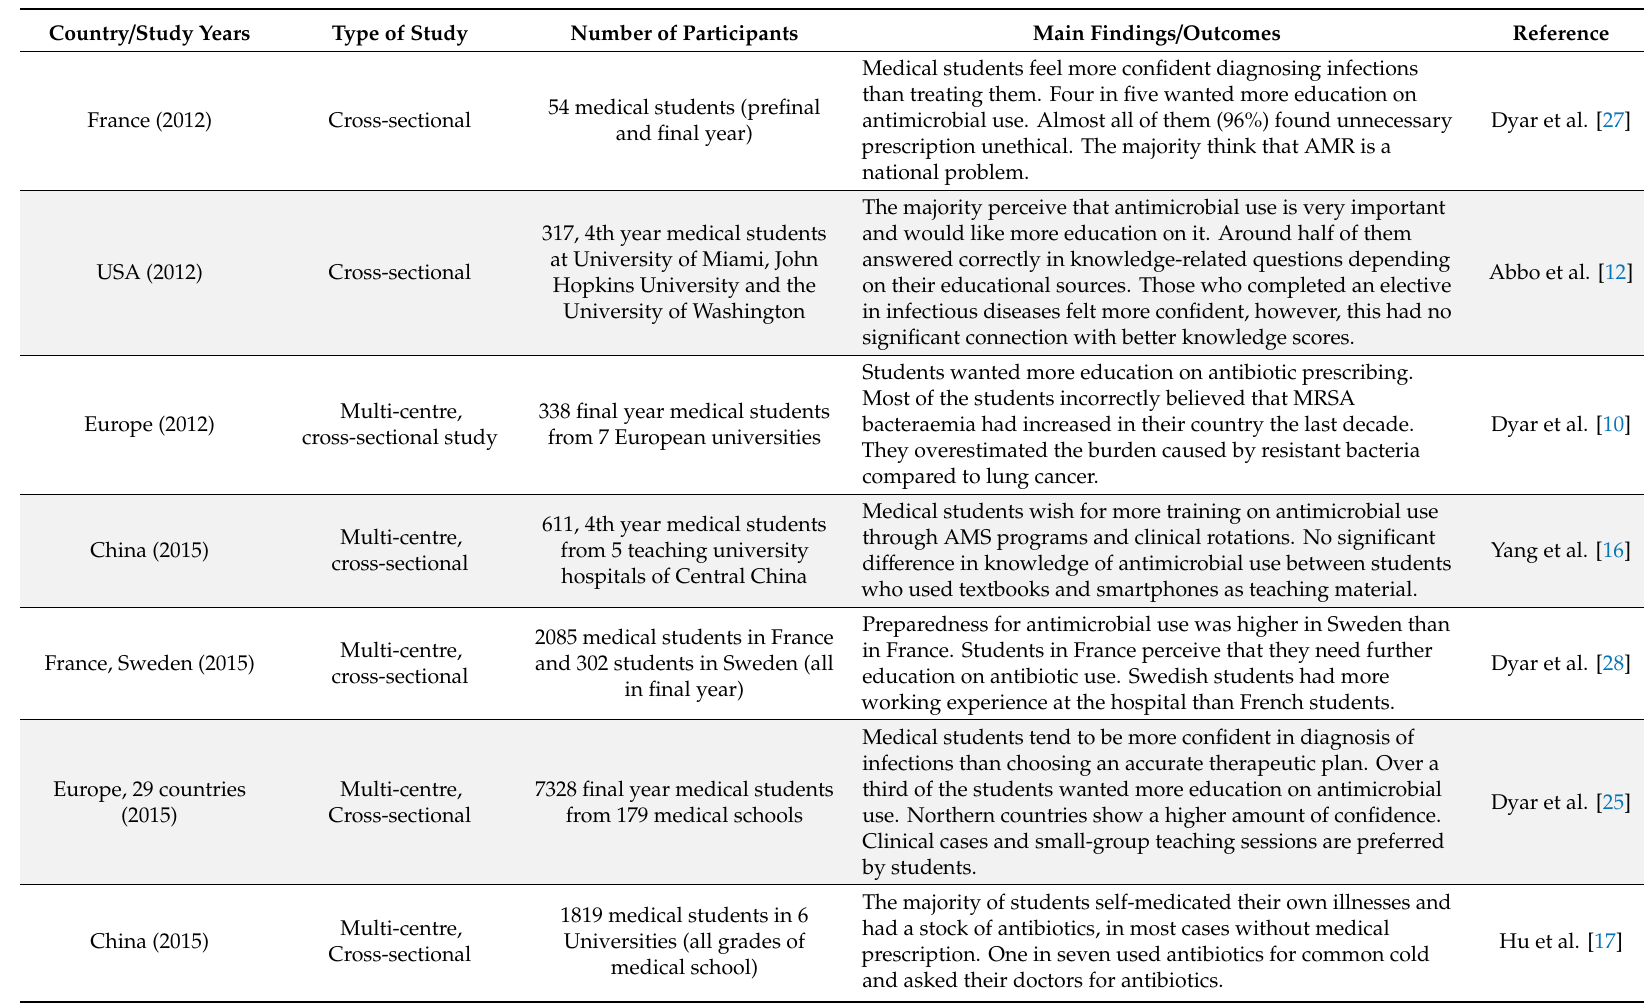
Table 1. Studies assessing knowledge, attitudes and perceptions of medical students regarding Antimicrobial Stewardship